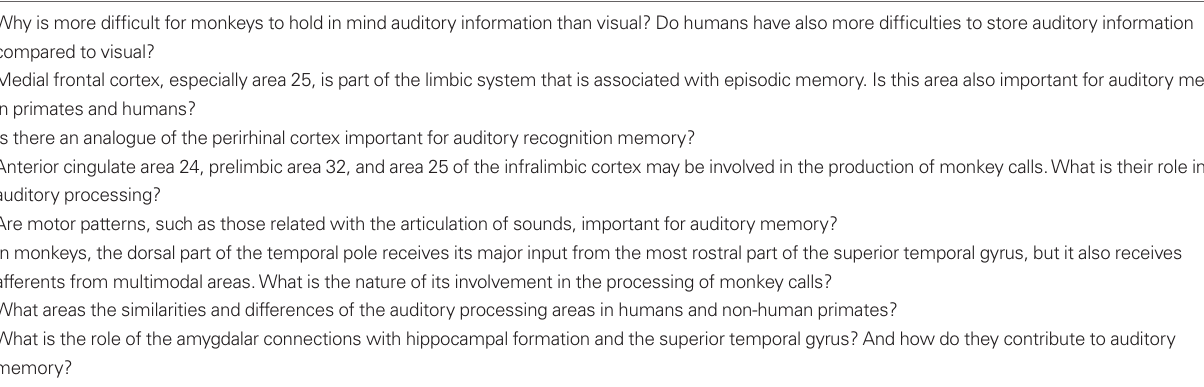
Table 1 | Some unresolved issues in the neuroanatomy of auditory memory. Why is more difficult for monkeys to hold in mind auditory information than visual? Do humans have also more difficulties to store auditory information compared to